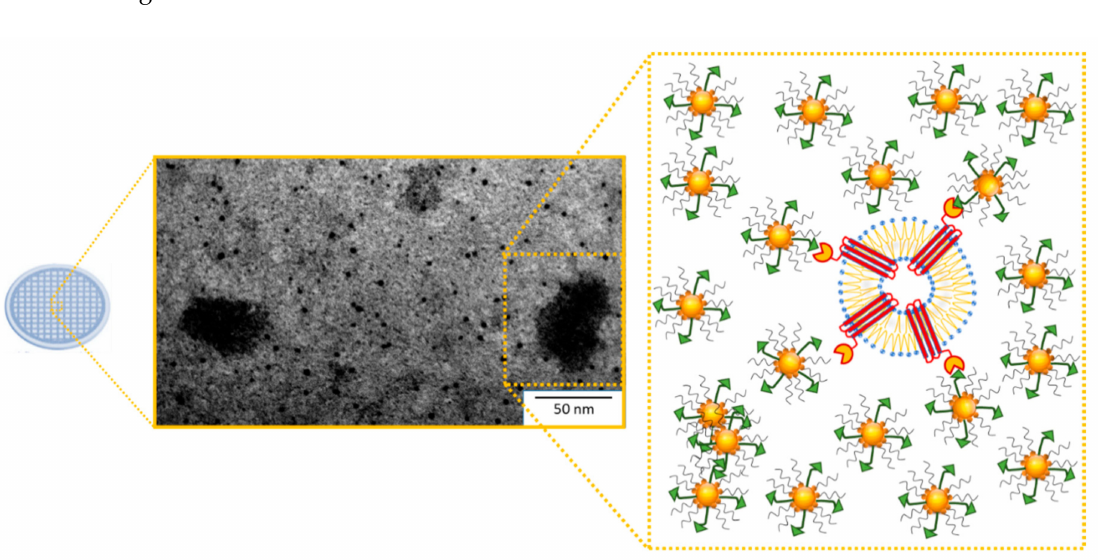
Figure 3. Immunogold labeling for the FZD10 protein on the exosome surface. Representative TEM micrograph obtained with the positive staining of exosomes derived from gastrointestinal cancer cells after their linking to FZD10 antibody-functionalized Au NPs by molecular recognition, along with the corresponding schematic